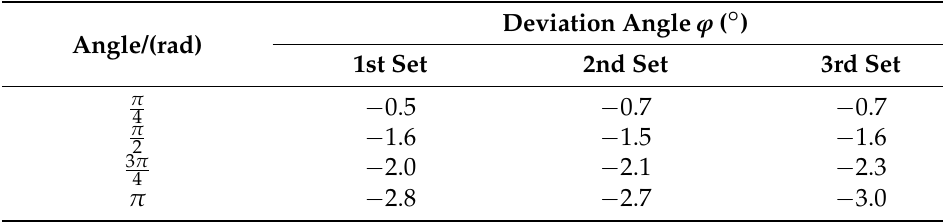
Table 5. Results of turning experiment in tracked mode.